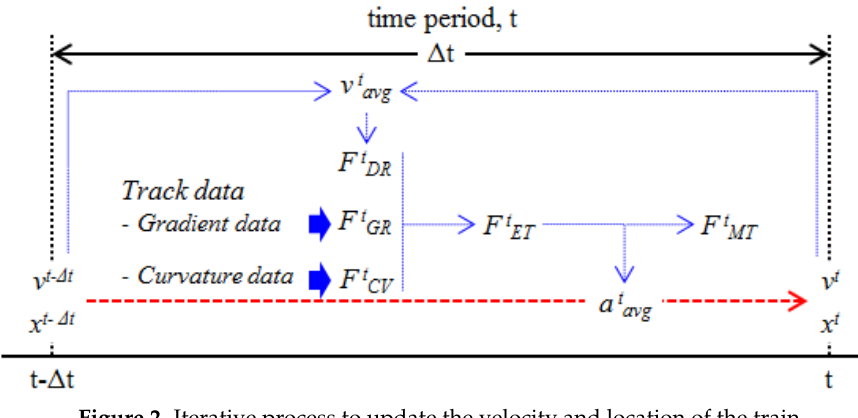
Figure 2. Iterative process to update the velocity and location of the train.